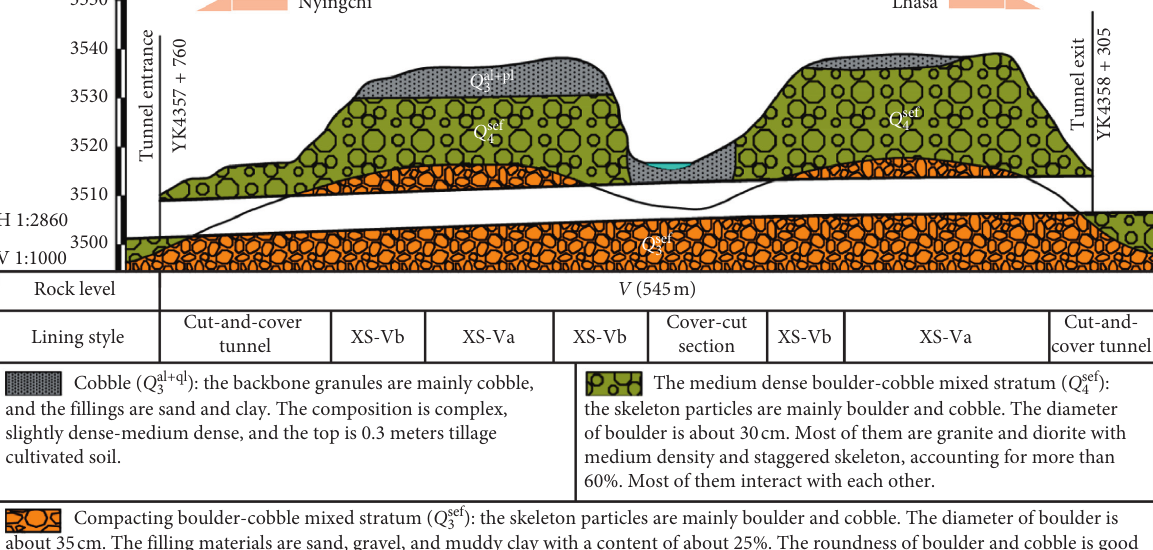
Figure 2: The geological section of the right line of the tunnel.